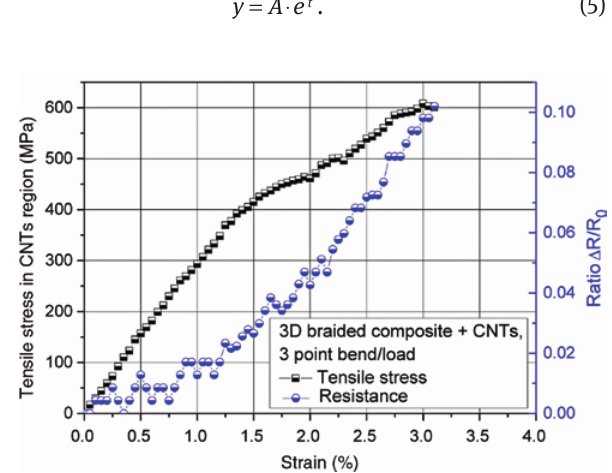
Figure 7: The strain and resistance change rate of sample A in three point bending test.